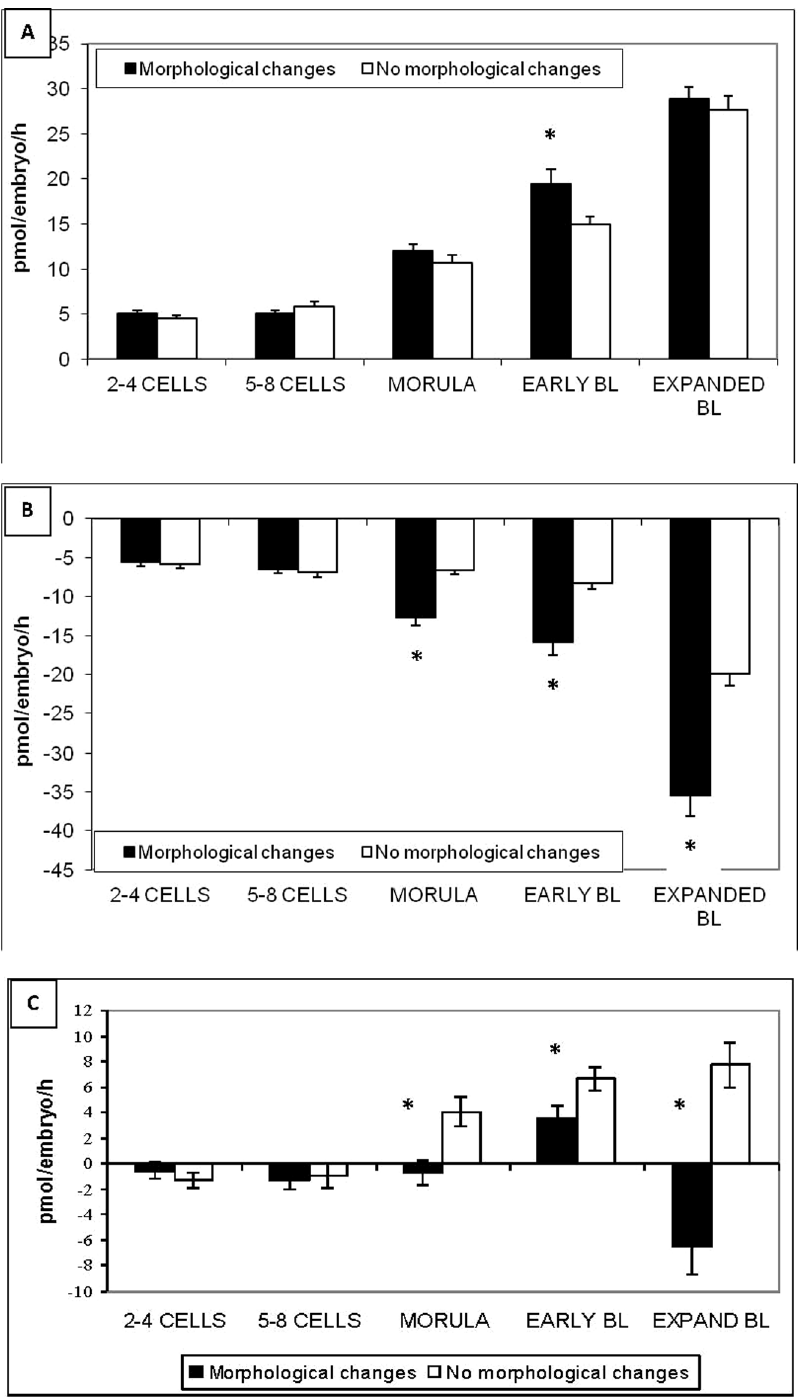
Figure 2. Amino acid production (A) and consumption (B) and balance (C) throughout preimplantation development by individual bovine embryos produced in vitro . Comparison between embryos with or without morphological changes after 24 hours of individual culture. Balance is the difference between amino acid consumption and production. *=p , 0.05.